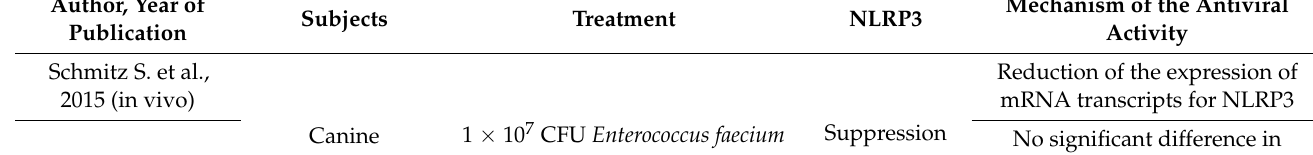
Table 1. Trials (in vivo, ex vivo) with probiotic administration and NLRP3 activation in animals and cell